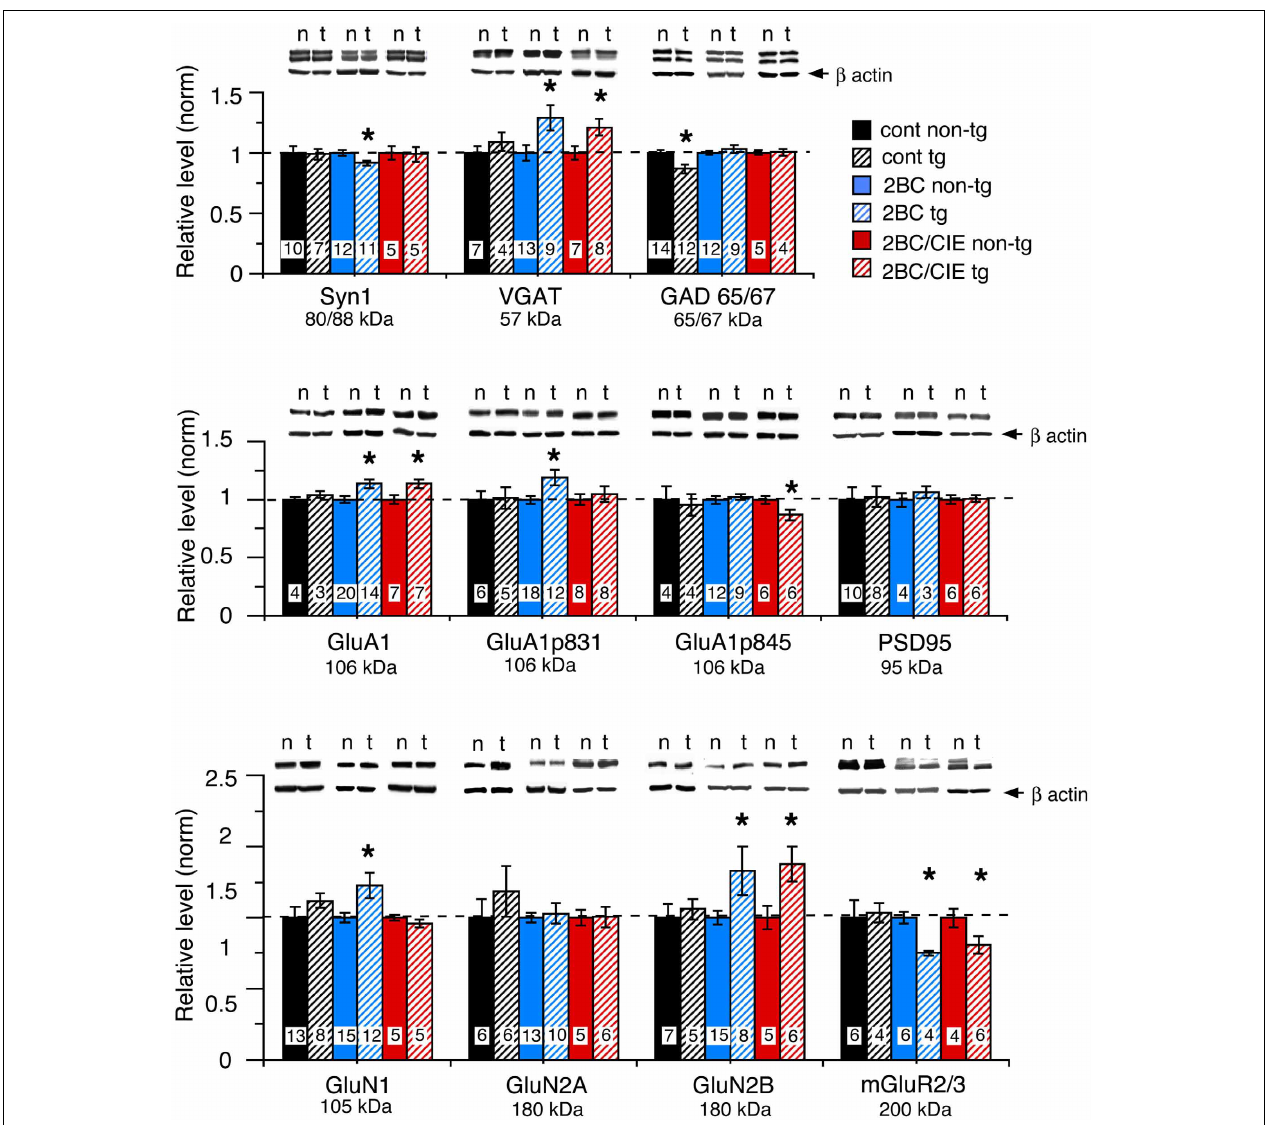
FIGURE 3 | Levels of synaptic proteins in CCL2-tg and non-tg hippocampus determined by Western blot. Values are mean ± SEM. Numbers in bars are the number of animals studied. Representative Western blots are shown above the respective bar graph. Top blot is the protein